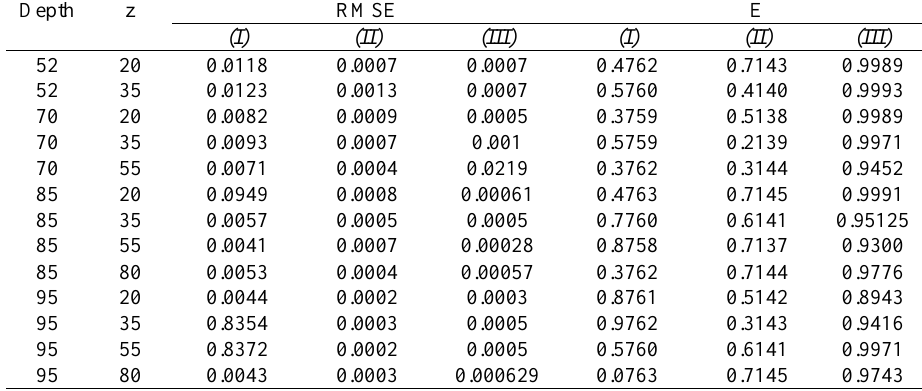
Table 10. The values of E and RMSE in the three Methods ( I, I and III